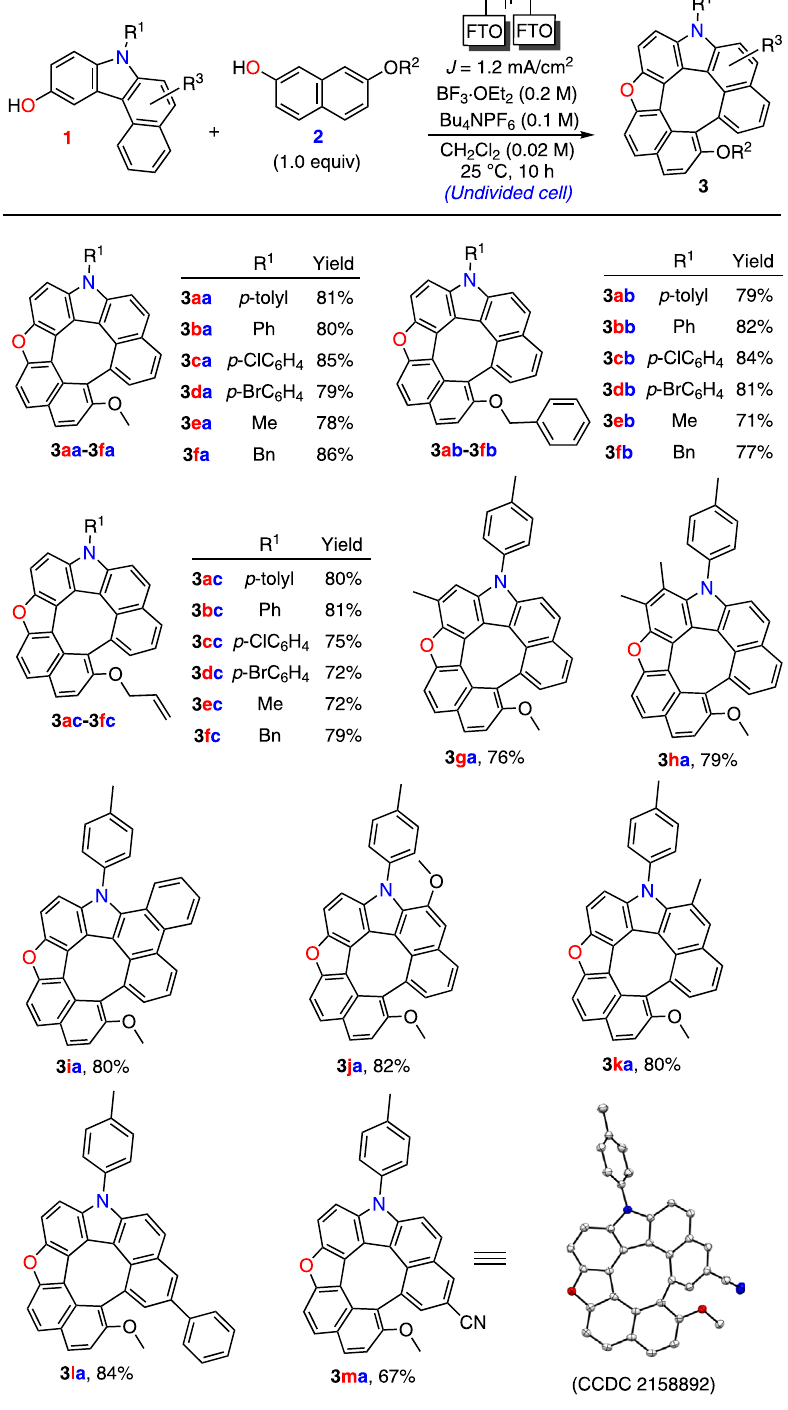
Fig. 2 Substrate-scope studies. Electrolysis conditions: FTO anode, FTO cathode, constant current = 3 mA ( J = 1.2 mA/cm 2 ), 1 and 2 (0.1 mmol), Bu 4 NPF 6 (0.1 M), BF 3 ·OEt 2 (0.2 M), CH 2 Cl 2 (5 mL), 25 °C, 10 Circular dichroism (CD) and circularly polarized luminescence (CPL) analysis of aza-oxa- dehydro[7]helicenes . HPLC using a chiral stationary phase (CHIRALPAK IC, hexane/ i -PrOH = 30:1), was used for the optical resolution of 3aa , 3ca and 3fa to analyze the racemization barriers of the obtained aza- oxa-dehydro[7] helicenes, (see Supplementary Note 2). The optical rotation values of